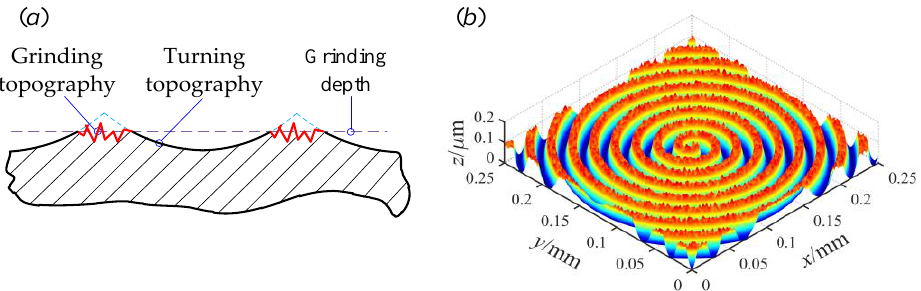
Figure 3. Surface topography under the combined machining mode. ( a ) The schematic diagram of the 2D topography; ( b ) The schematic diagram of the 3D topography.